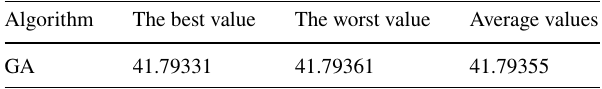
Table 4 Statistical characteristics of the GA performance